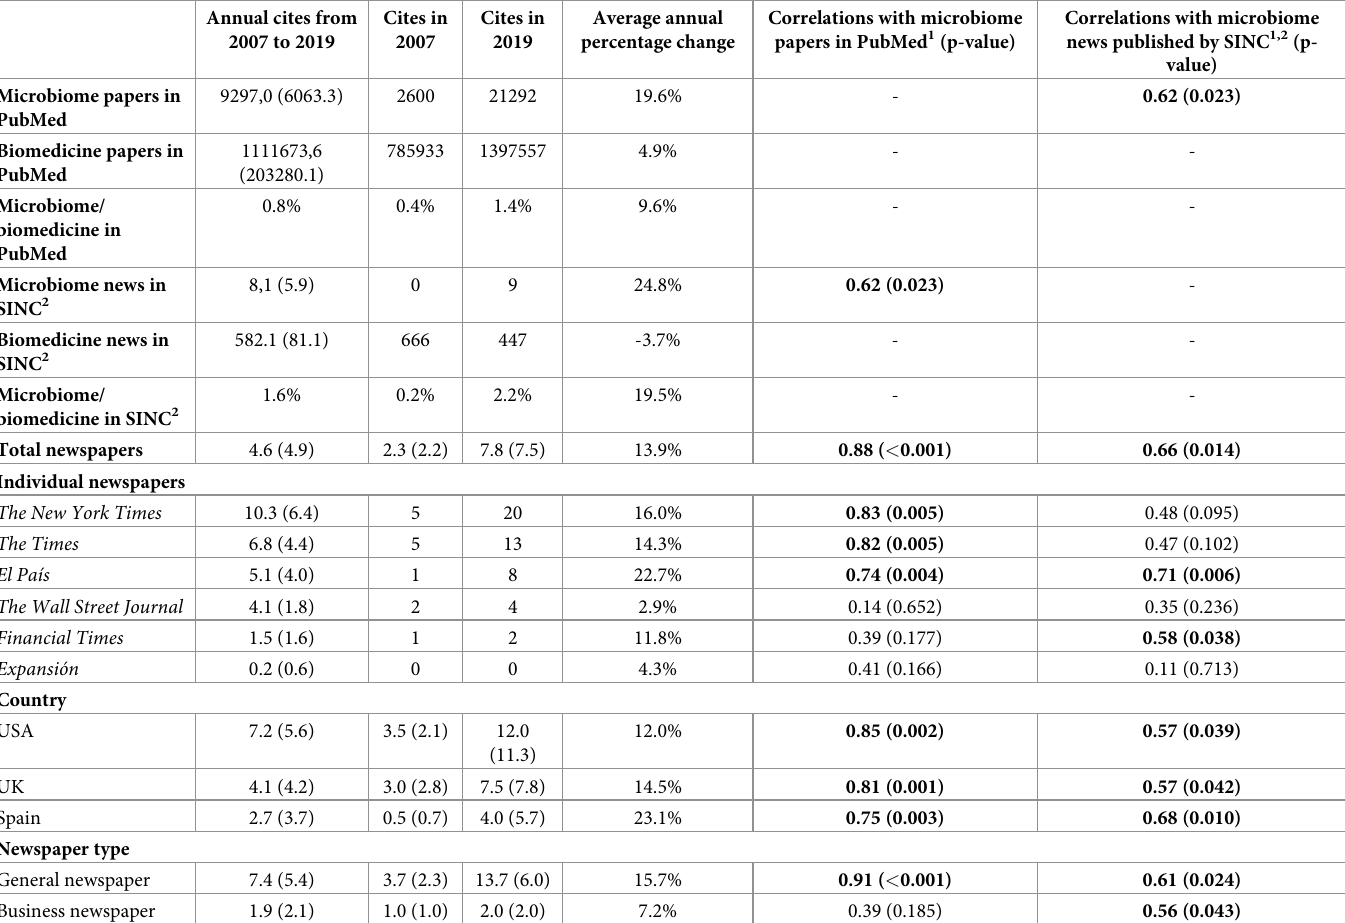
Table 1. Number of news stories on microbiome papers, microbiome papers in PubMed, microbiome news published by SINC and correlations between